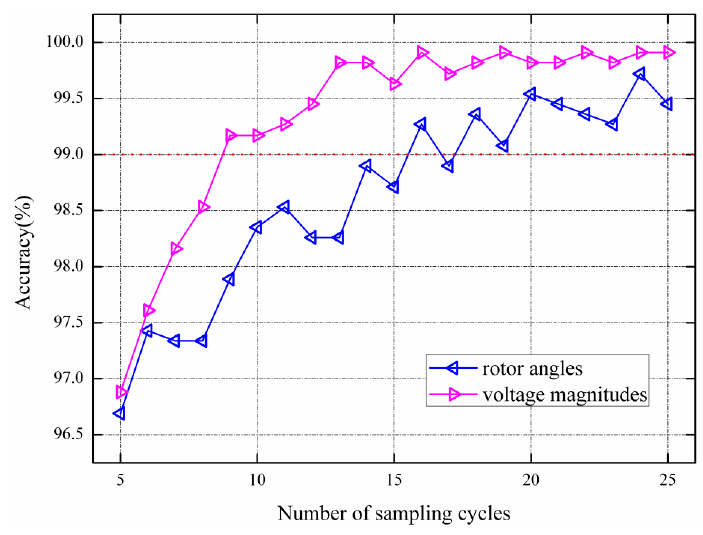
Figure 8. Accuracy variation for different sampling cycles.